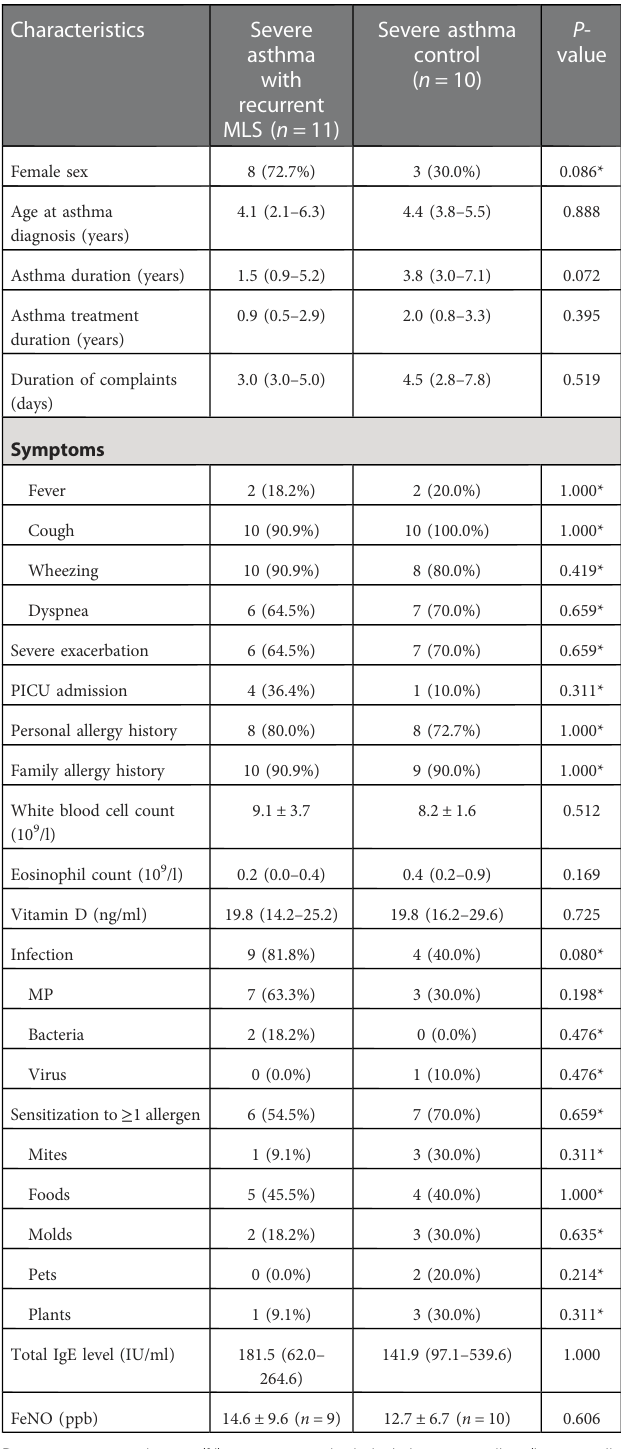
TABLE 2 Clinical features of children with severe asthma strati fi ed by recurrent MLS.